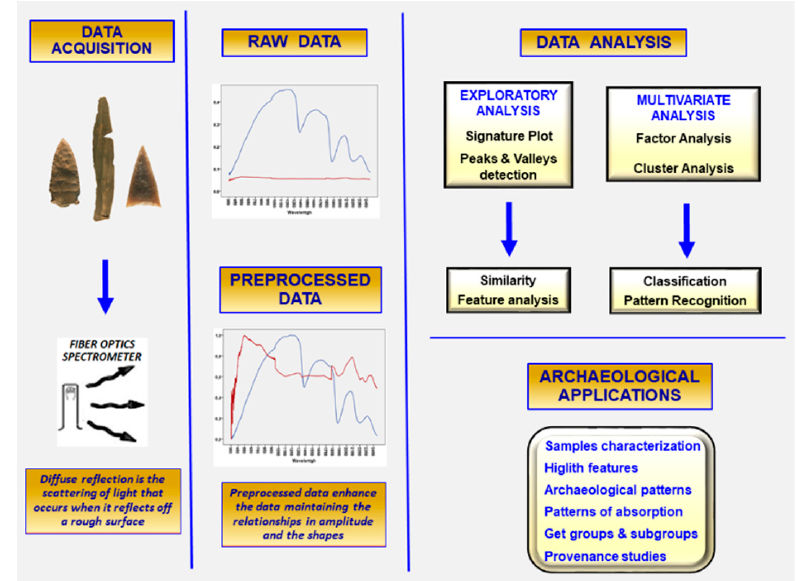
Figure 3. Graphic diagram of the proposed methodology.